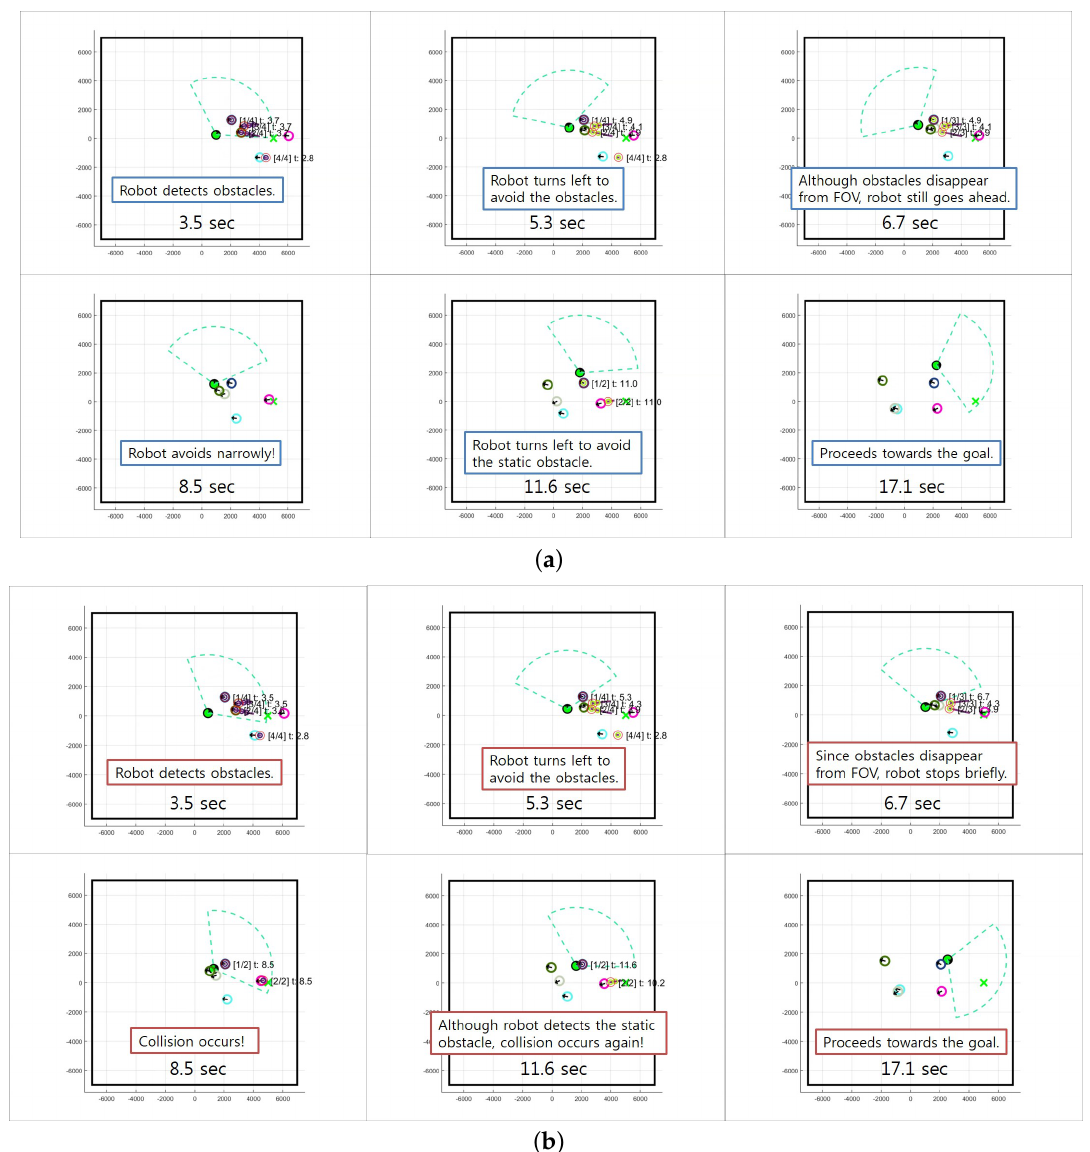
Figure 9. Snapshots from a motion control simulation with five dynamic obstacles using: ( a ) FactGP C ; and ( b ) GP-MC.